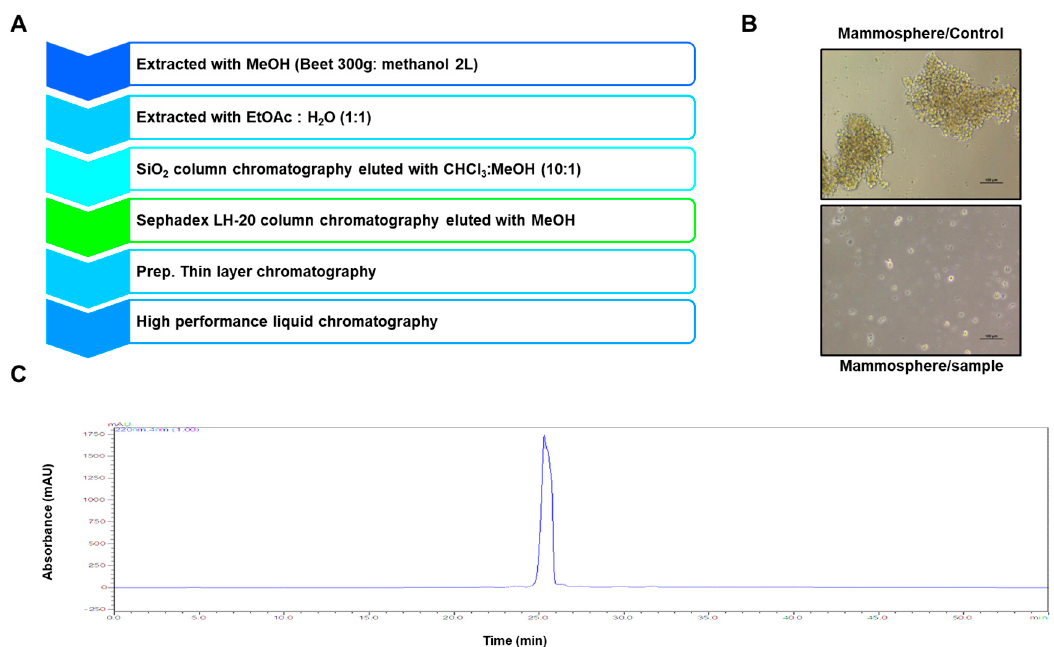
Figure 1. Identification of a breast cancer stem cell (BCSC) inhibitor isolated from beet extracts via a